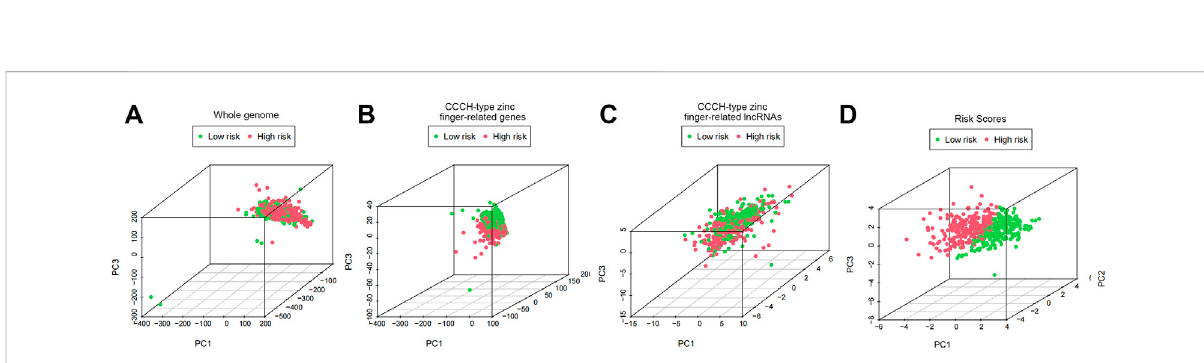
FIGURE 9 PCA pro fi les showed patient distribution based on (A) Whole genome; (B) CCCH-type zinc fi nger-related genes; (C) CCCH-type zinc fi nger- related lncRNAs; and (D) Risk Scores. In the high and low risk groups, red and green dots were more strongly